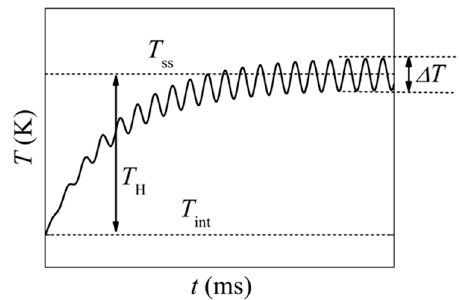
Figure 3. Illustration of the temperature of the metal film as a function of time after starting the measurement. The total time dependence of the temperature is a sum of the self-heating ( T H ) and an oscillating temperature with a frequency of 2 ω .